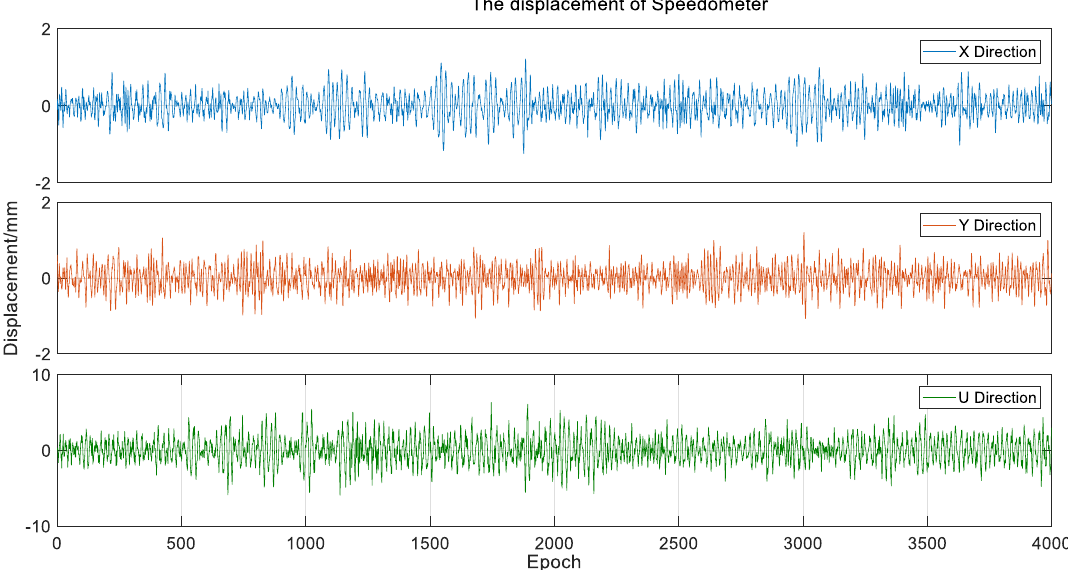
Figure 21. The displacement calculated by the speedometer data.